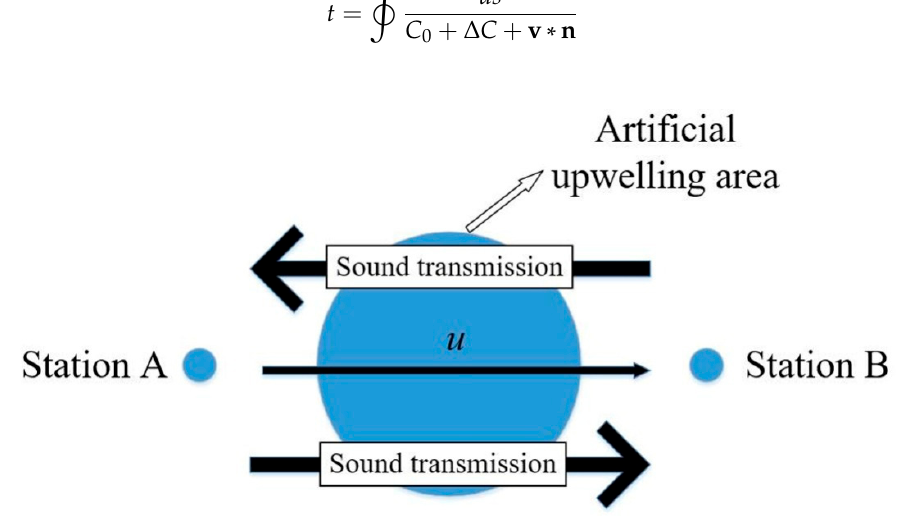
Figure 2. Diagram of reciprocal sound waves.